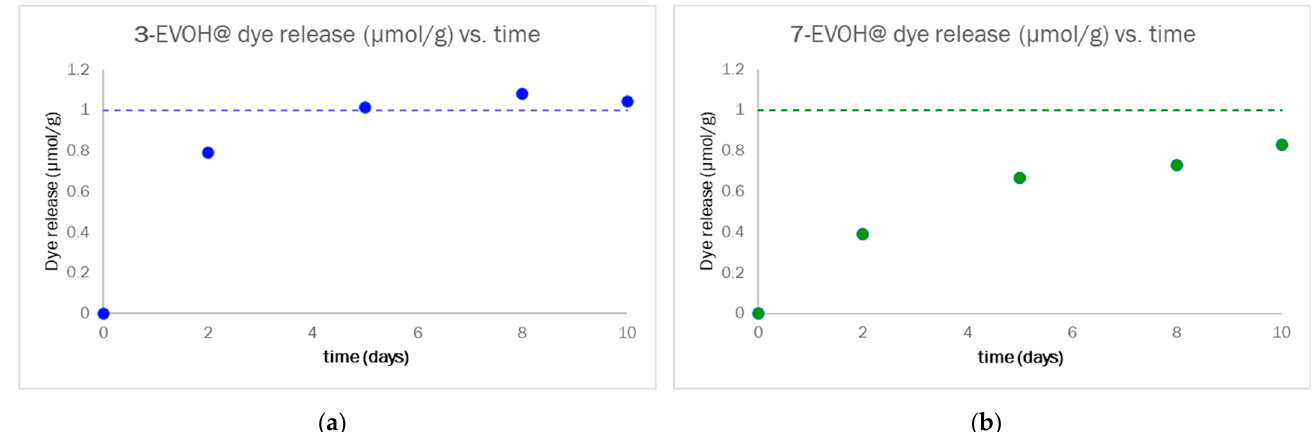
Figure 8. Dye release evolution for 10 days of monitoring for 3-EVOH@ ( a ) and 7-EVOH@ ( b ).